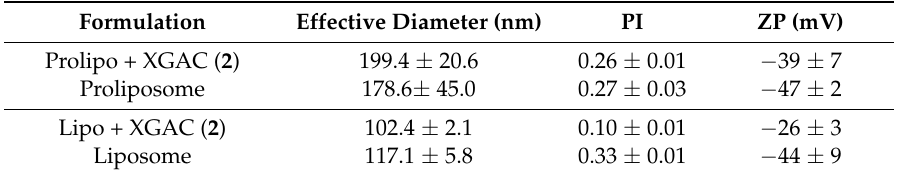
Table 3. Results obtained (mean diameter, PI and ZP) for proliposome (prepared with manual agitation and water) and liposomal formulations, with and without xanthone 2